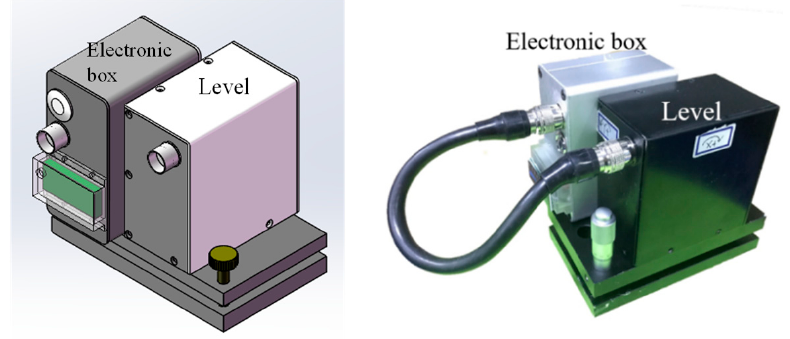
Figure 5. The prototype of the dual-axis precision level: 3D design and photo.